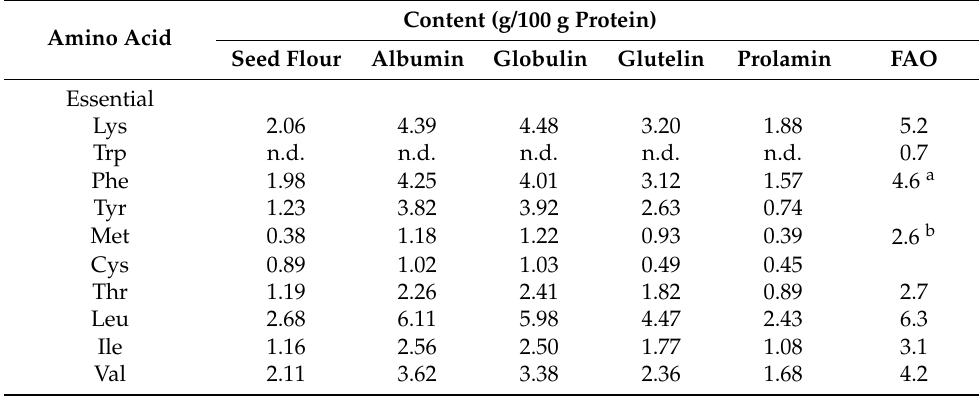
Table 1. Amino acid composition (g/100 g of protein) of Erythrina edulis flour and its protein